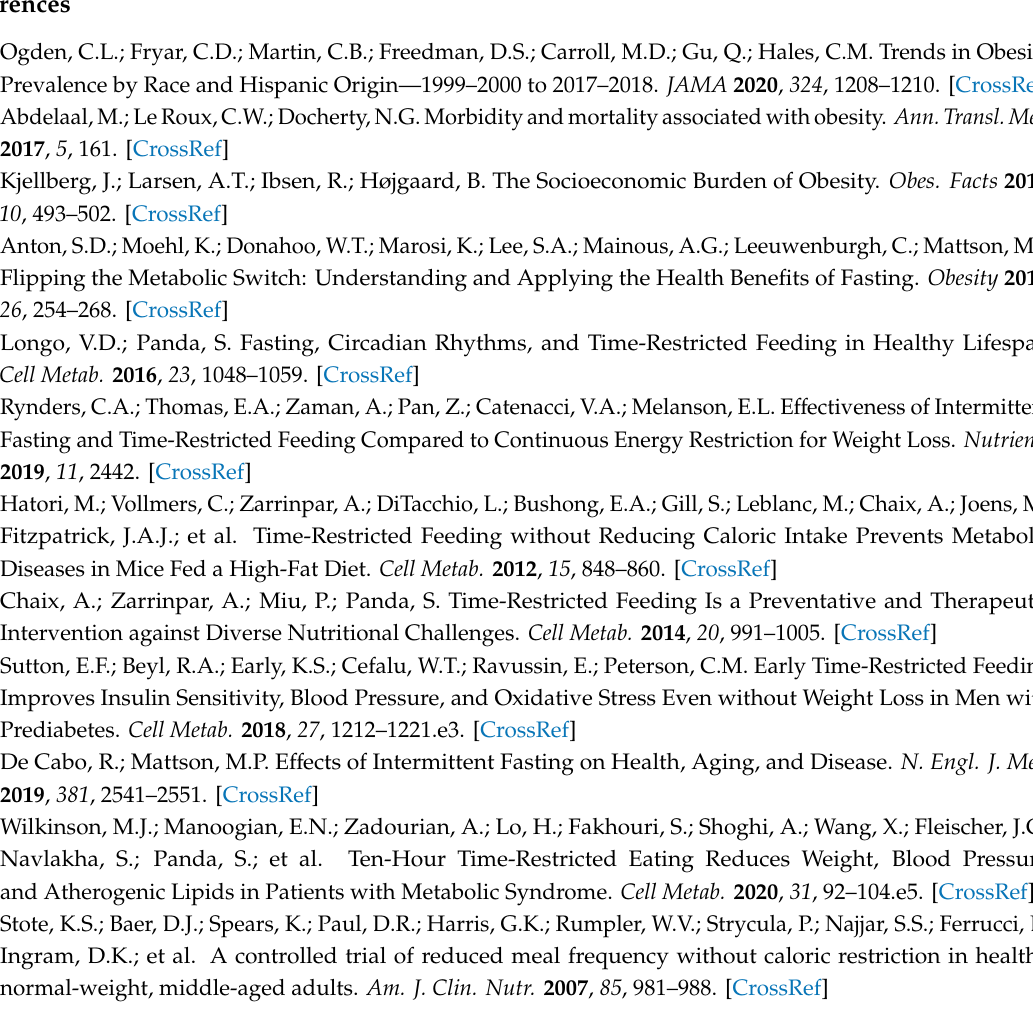
Table S1 Title: Food categories and their nutrient properties as the base for categorization of Eos. Table S2 Title: Baseline Characteristics of study participants. Table S3 Title: Correlation between weight loss and change in eating occasion, food types, and